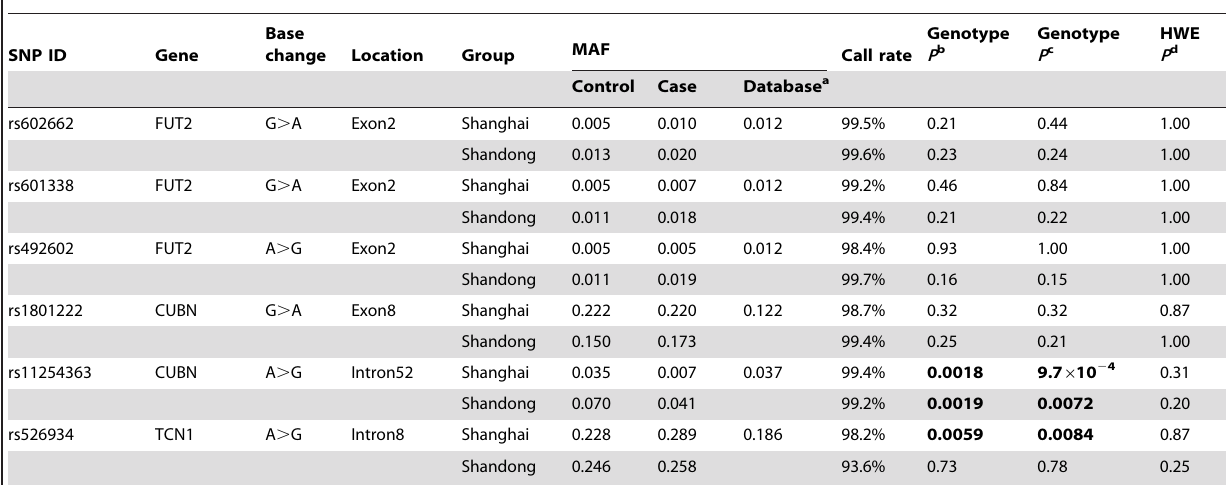
Table 1. The SNPs investigated in the association study.